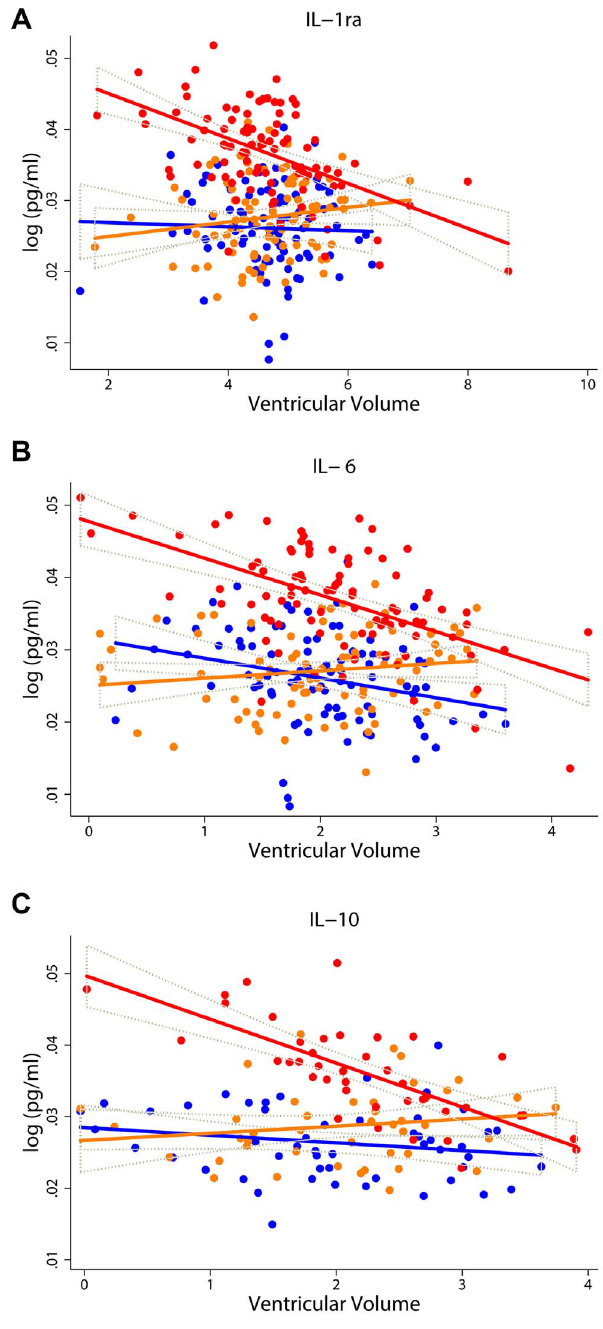
Figure 1. Association between inflammatory proteins levels measured in plasma versus ventricular volume. Scatter diagram with regression lines show the relationship between proteins levels of IL-1ra (N = 86) (figure 1A), IL-6 (N = 83) (figure 1B) and IL-10 (N=38)(figure 1C)and ventricular volume in the three separate diagnostic groups. Keys: Blue line and dots denote control samples; orange line and dots denote MCI samples; red line and dots denote AD samples; brown dotted line denotes 95% CI.